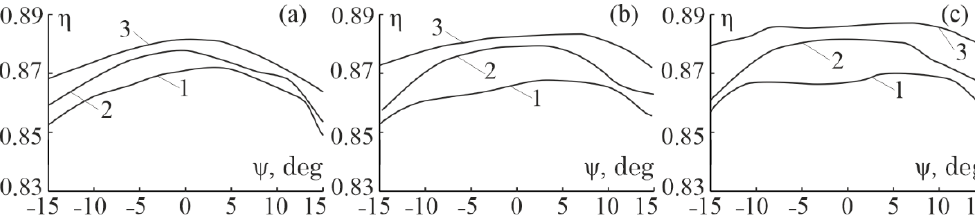
Figure 5. The calculated DE dependence on the angle of incidence for microstructures No. 4 of Table 2. At λ = 0.4 μ m (1); at λ = 0.55 μ m (2); At λ = 0.7 μ m (3). ( a – c ) correspond to P = 10, P = 20 and P = 30.